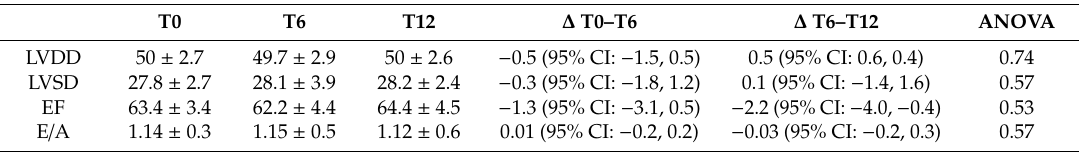
Table 2. Echocardiographic parameters.